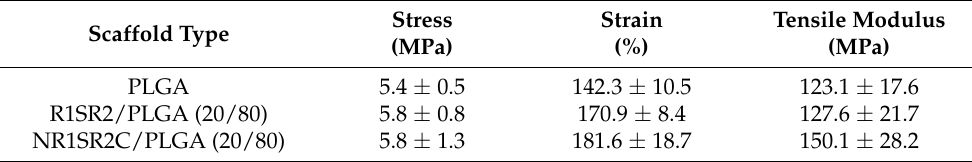
Figure 5. Representative stress–strain curves for recombinant MiSp/PLGA (20/80) blend and pure PLGA scaffolds. Table 2. Mechanical features of nanofibrous membranes (6 times per membrane).